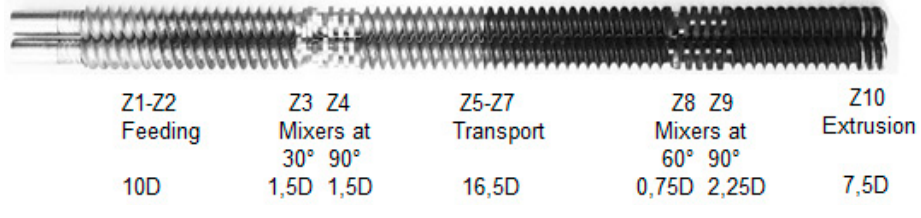
Figure 1. Screw configuration used in the study.